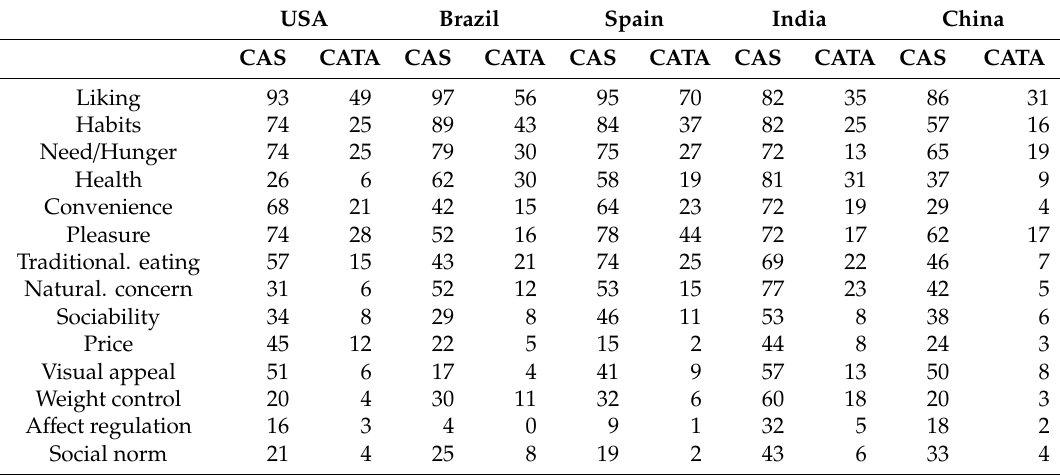
Table A1. Percentage of “agree” responses for CAS and CATA for all five countries for the respective protein-rich